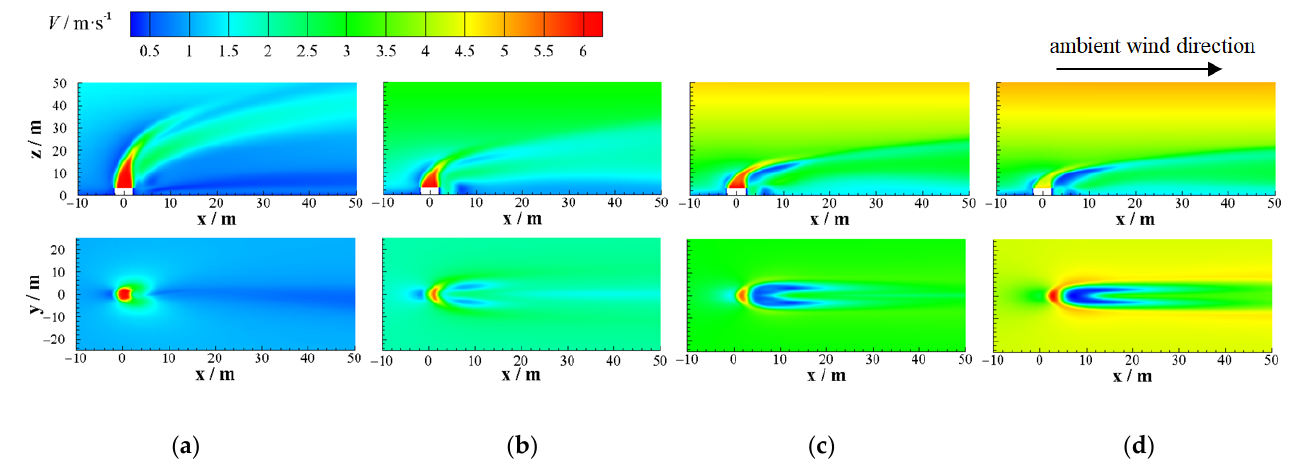
Figure 9. Velocity profiles of the vertical outlet when V 0 = 6 m/s without considering the ambient wind: ( a ) U = 1 m/s; ( b ) U = 2 m/s; ( c ) U = 3 m/s; ( d ) U = 4 m/s.